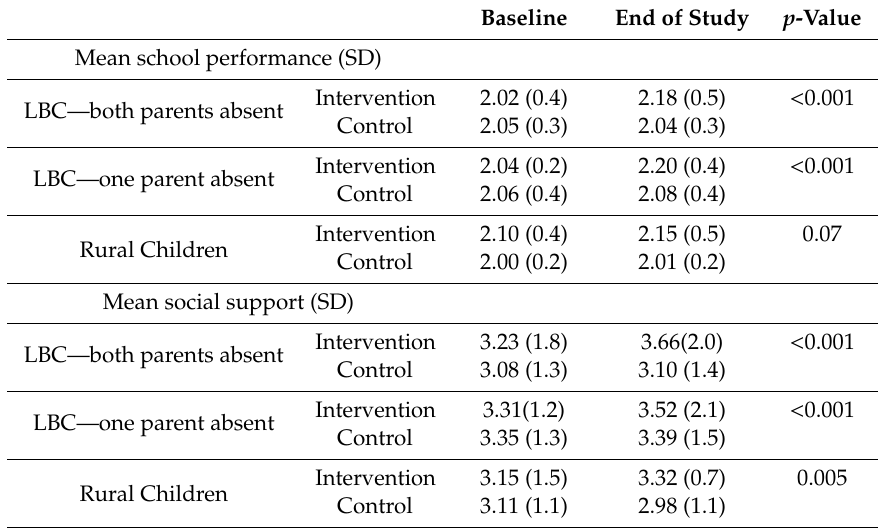
Table 3. Baseline and end-of-study assessments, mean school performance and social support, of children in intervention villages and control villages by left-behind